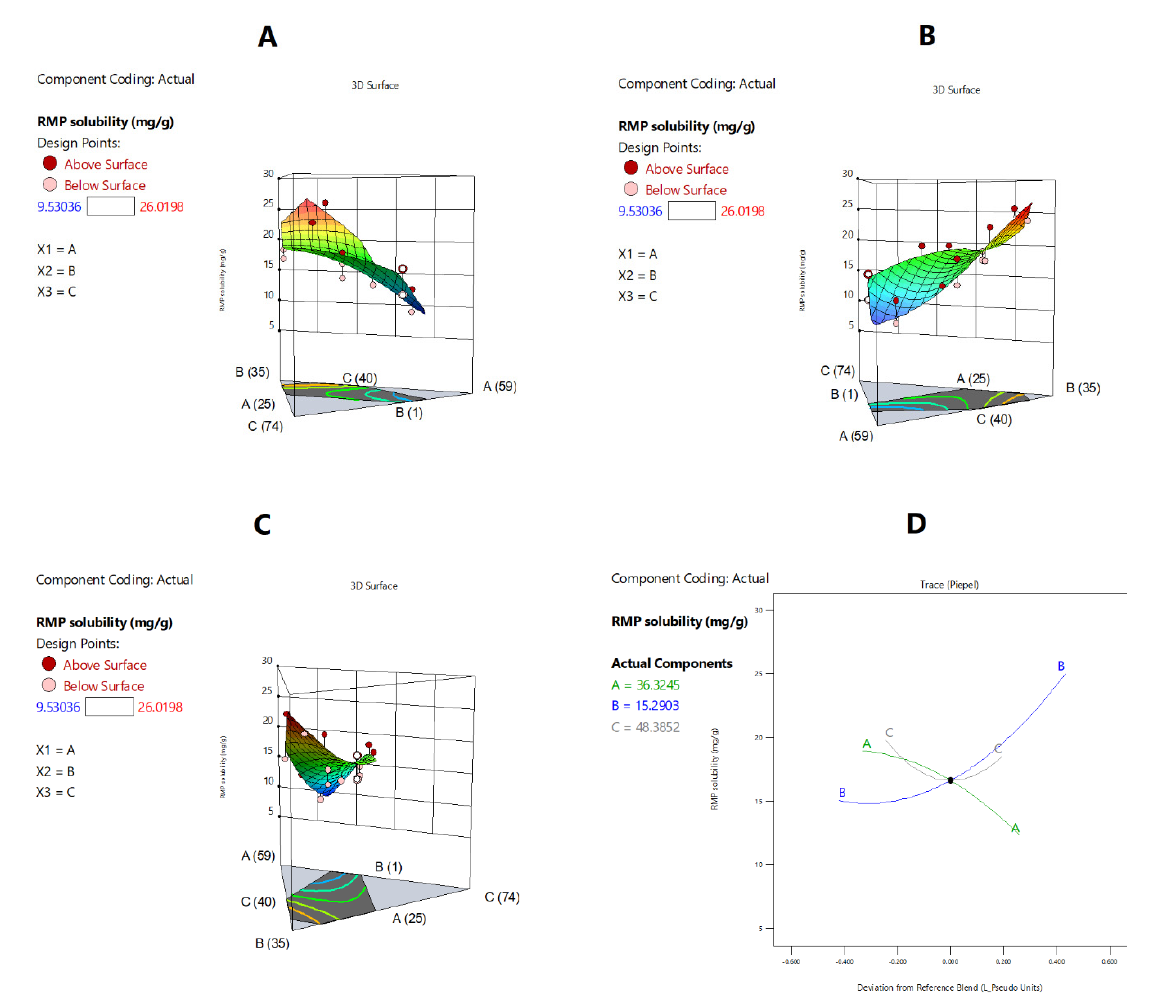
Figure 5. Graphical representation of the formulation components’ effects on RMP apparent solubility: ( A – C ) The 3D surface representations of the effects of the proportions of BSO, TCP, and HCO-30, respectively, on RMPapparent solubility. ( D ) Trace-type representation of the effects of the formulation components on apparent solubility. A: BSO % w / w ; B: TCP % w / w ; C: HCO-30 % w / w . Table 5. Analysis of variance (ANOVA) of the quadratic model presenting the correlation between independent formulation variables and RMP apparent solubility.